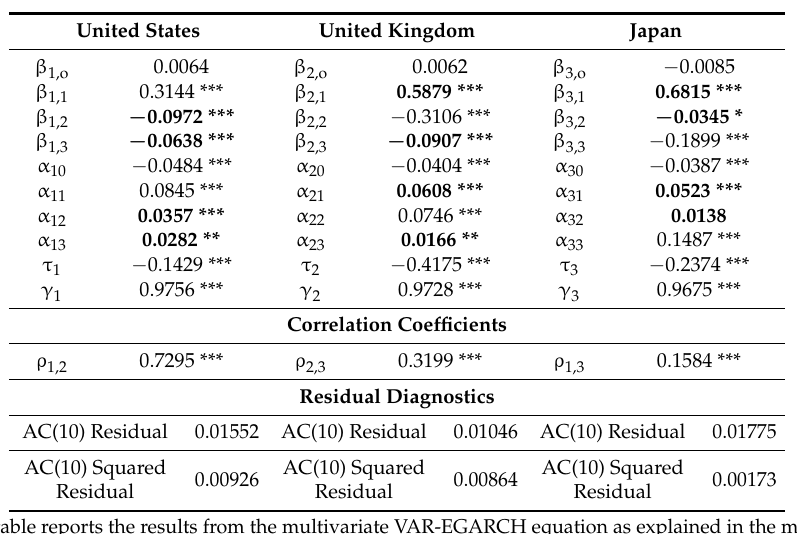
Table 4. Estimation from the multivariate MVR-EGARCH model (conventional